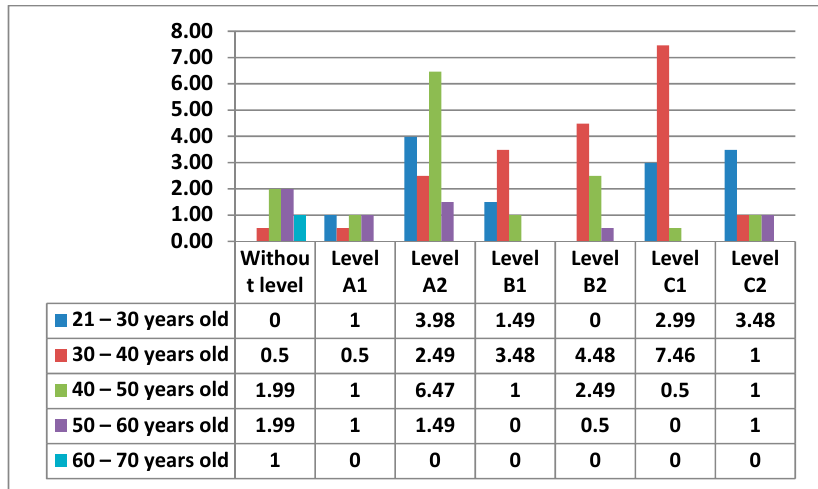
Figure 20. Digital competence in women by age in Area 3. Int. J. Environ. Res. Public Health 2020 , 17 , x